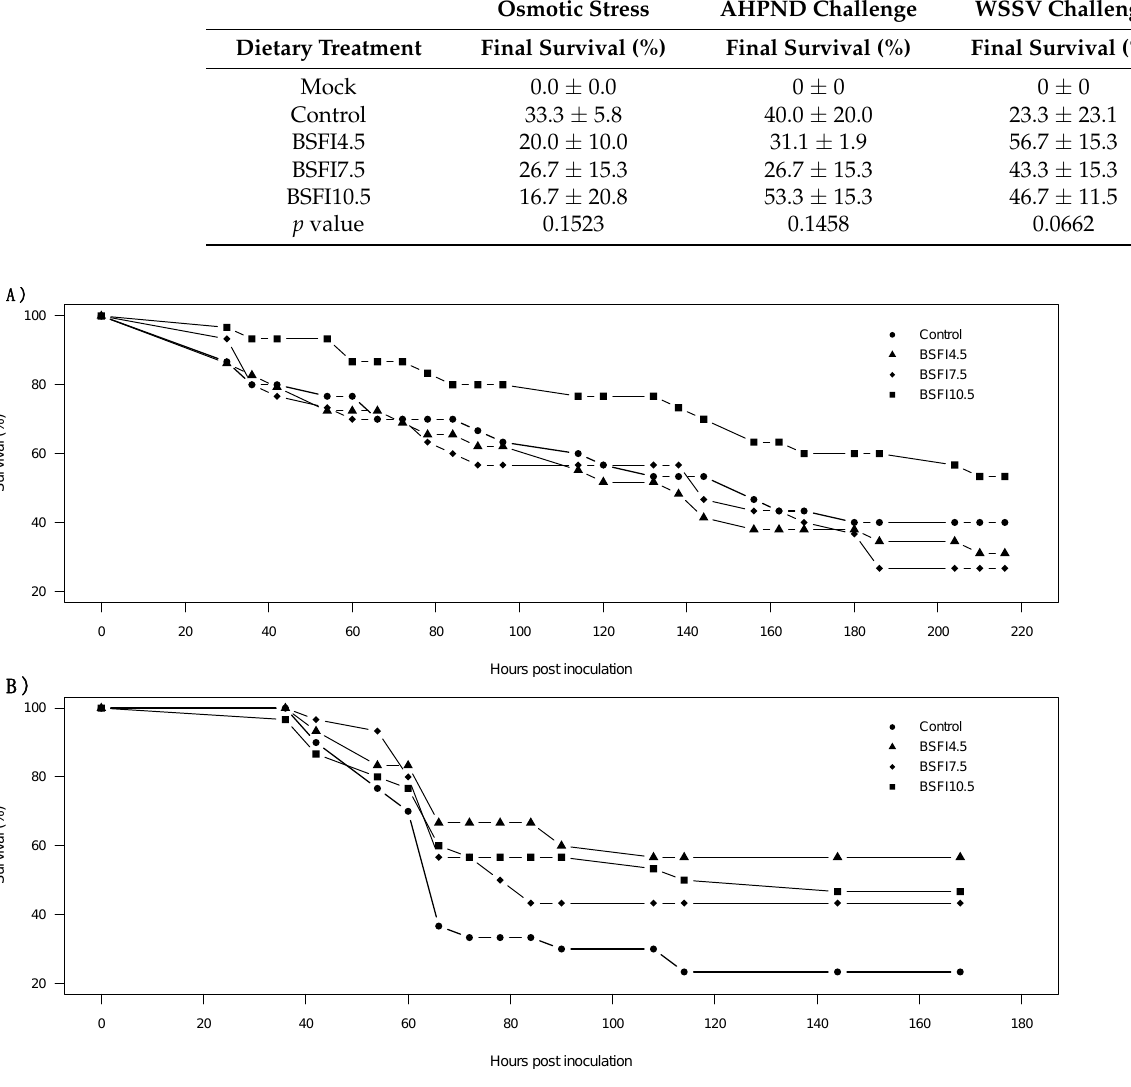
Figure 1. Survival curves of the acute hepatopancreatic necrosis disease (AHPND) ( A ) and white spot syndrome virus (WSSV) ( B ) disease challenge trials of Litopenaeus vannamei fed the four experimental diets (Control, and experimental diets with 4.5, 7.5 and 10.5% functional ingredient derived from H. illucens (BSFI), respectively BSFI4.5, BSFI7.5, and BSFI10.5). Survival curves were statistically similar among dietary treatments (AHPND p = 0.15, WSSV p = 0.07). Table 3. Survival of Litopenaeus vannamei exposed to osmotic stress, acute hepatopancreatic necro- sis disease (AHPND), or white spot syndrome virus (WSSV). Shrimp were fed four experimental diets over 28 days (control, and experimental diets with 4.5%, 7.5%, and 10.5% Black soldier fly derived novel feed ingredient, respectively BSFI4.5, BSFI7.5, and BSFI10.5), survival is presented as mean ± standard deviation.